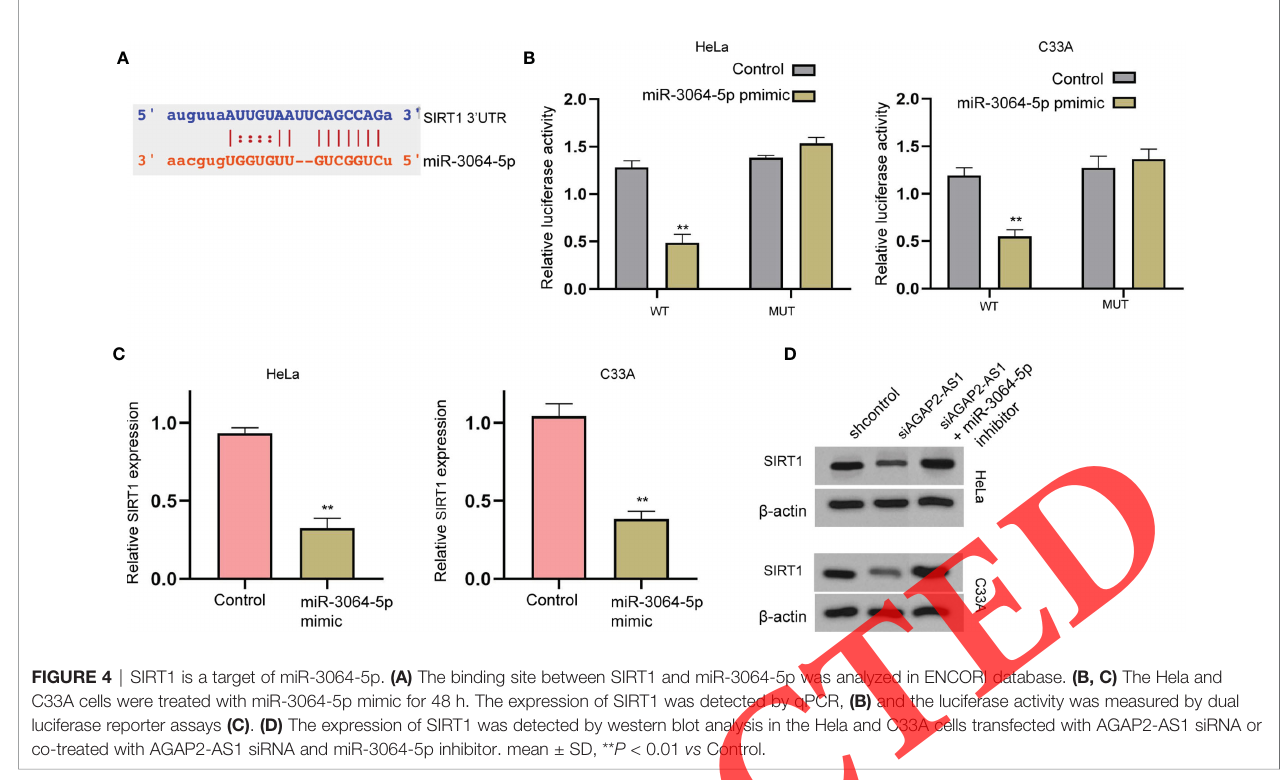
FIGURE 4 | SIRT1 is a target of miR-3064-5p. (A) The binding site between SIRT1 and miR-3064-5p was analyzed in ENCORI database. (B, C) The Hela and C33A cells were treated with miR-3064-5p mimic for 48 h. The expression of SIRT1 was detected by qPCR, (B) and the luciferase activity was measured by dual luciferase reporter assays (C) . (D) The expression of SIRT1 was detected by western blot analysis in the Hela and C33A cells transfected with AGAP2-AS1 siRNA or co-treated with AGAP2-AS1 siRNA and miR-3064-5p inhibitor. mean ± SD, ** P < 0.01 vs Control.